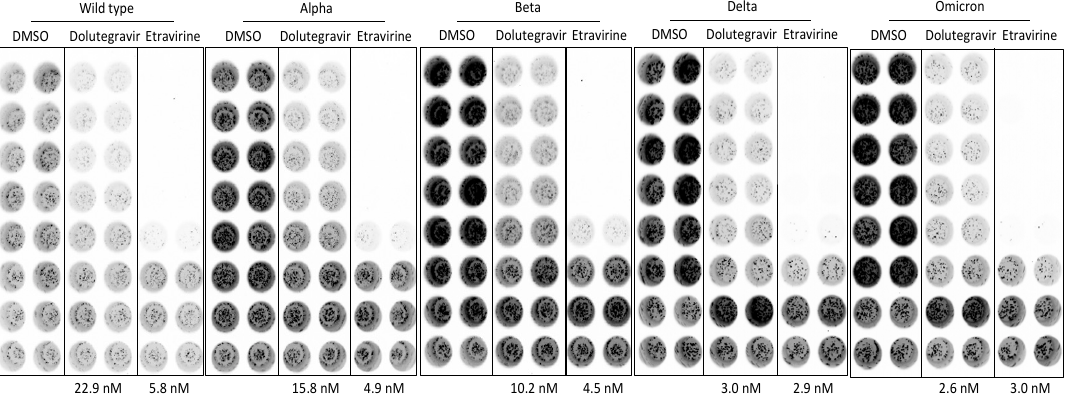
Figure 6. Neutralization activities of entry inhibitors against pseudoviruses carrying spike proteins of major SARS-CoV-2 variants. SmBiT-ACE2 cells were infected with SARS-CoV-2-pseudotyped viruses mixed with indicated DMSO, Dolutegravir, or Etravirine for 6 h and then removed from culture. Following 24 h post infection, bioluminescence signals of infected cells were detected by a bioluminescence imager and bioluminescent plate reader. Representative bioluminescence images of pseudotyped virus infection are shown. EC50 values of indicated entry drugs against different variants are